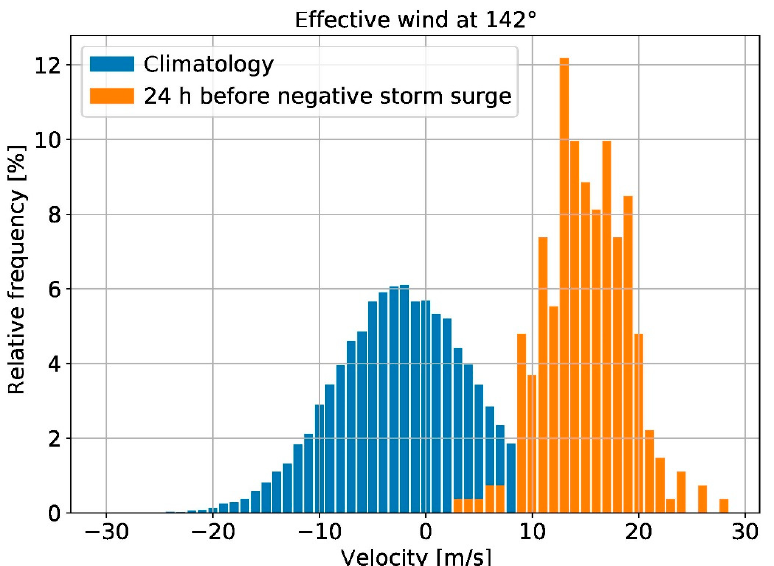
Figure 11. Distribution of the effective wind at 142° for the whole time period 1950–2019 (climatol- ogy, blue) and for the 24 h before the respective 271 ELWs (orange). blue) and for the 24 h before the respective 271 ELWs